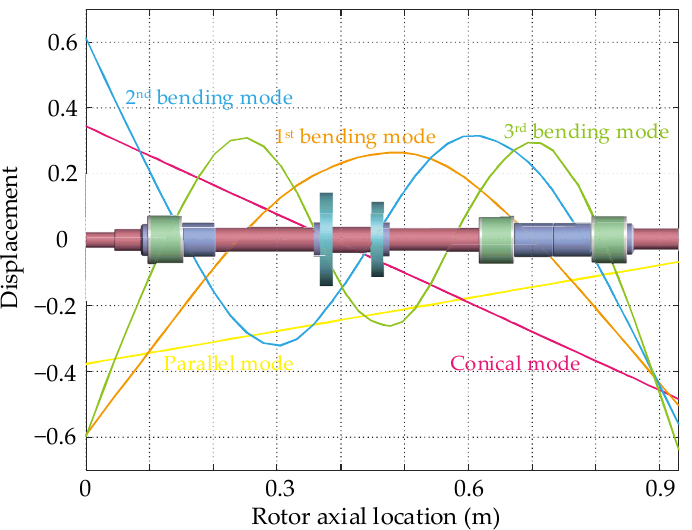
Figure 5. Modal shape of the flexible rotor.